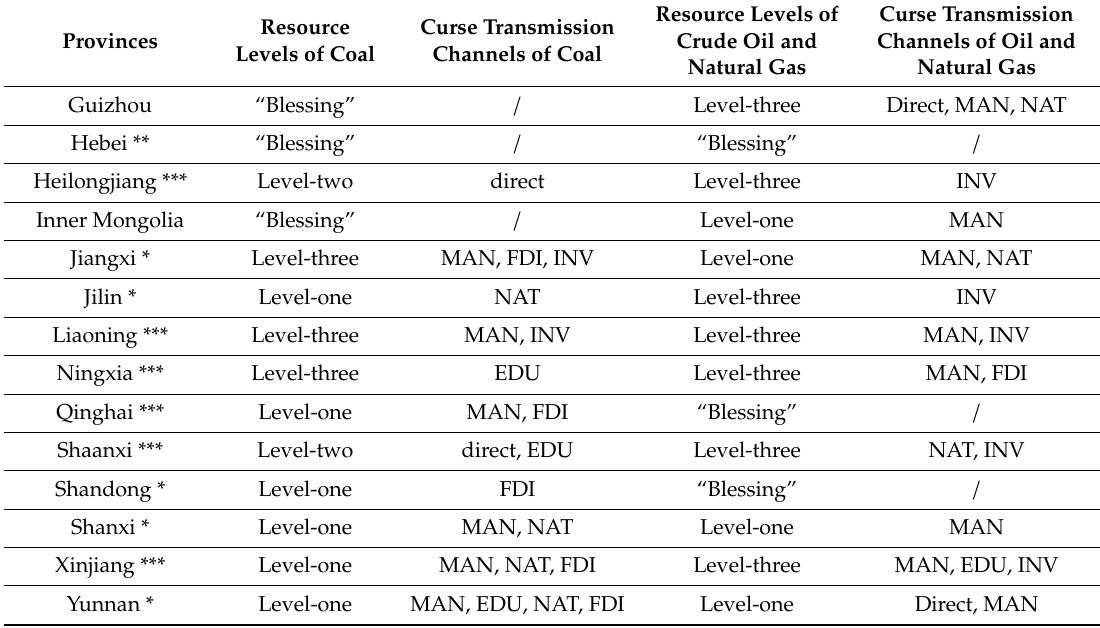
Table 9. Energy resource curse level of di ff erent resource